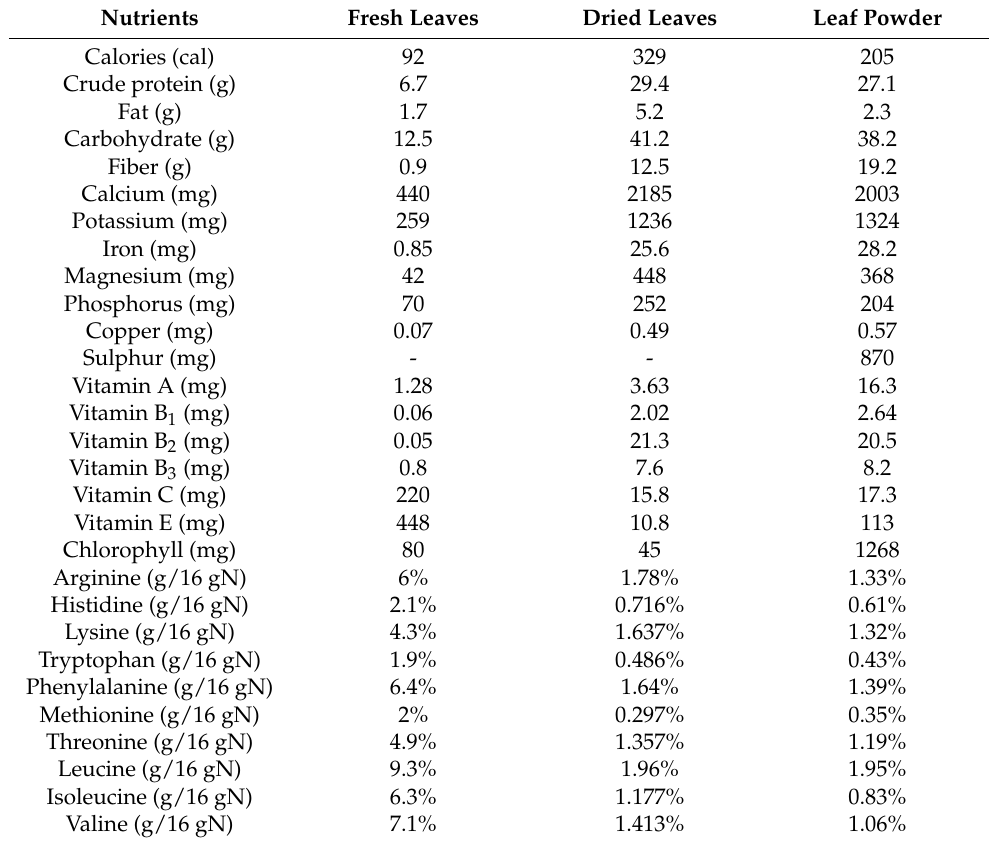
Data adapted from [16,17] and all values are per 100 g of plant